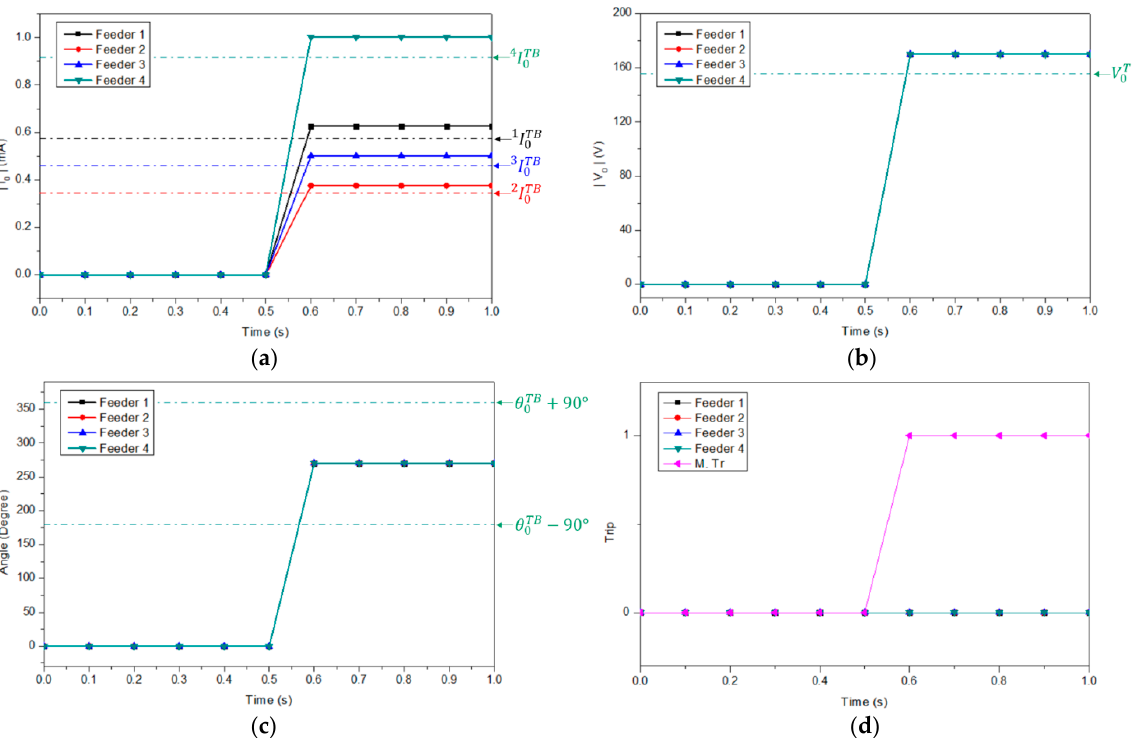
Figure 13. Test results for a busbar SLG fault with a resistance of 3 k Ω . ( a ) Zero-sequence current. ( b ) Zero-sequence voltage. ( c ) Zero-sequence angle difference. ( d ) Trip signal.